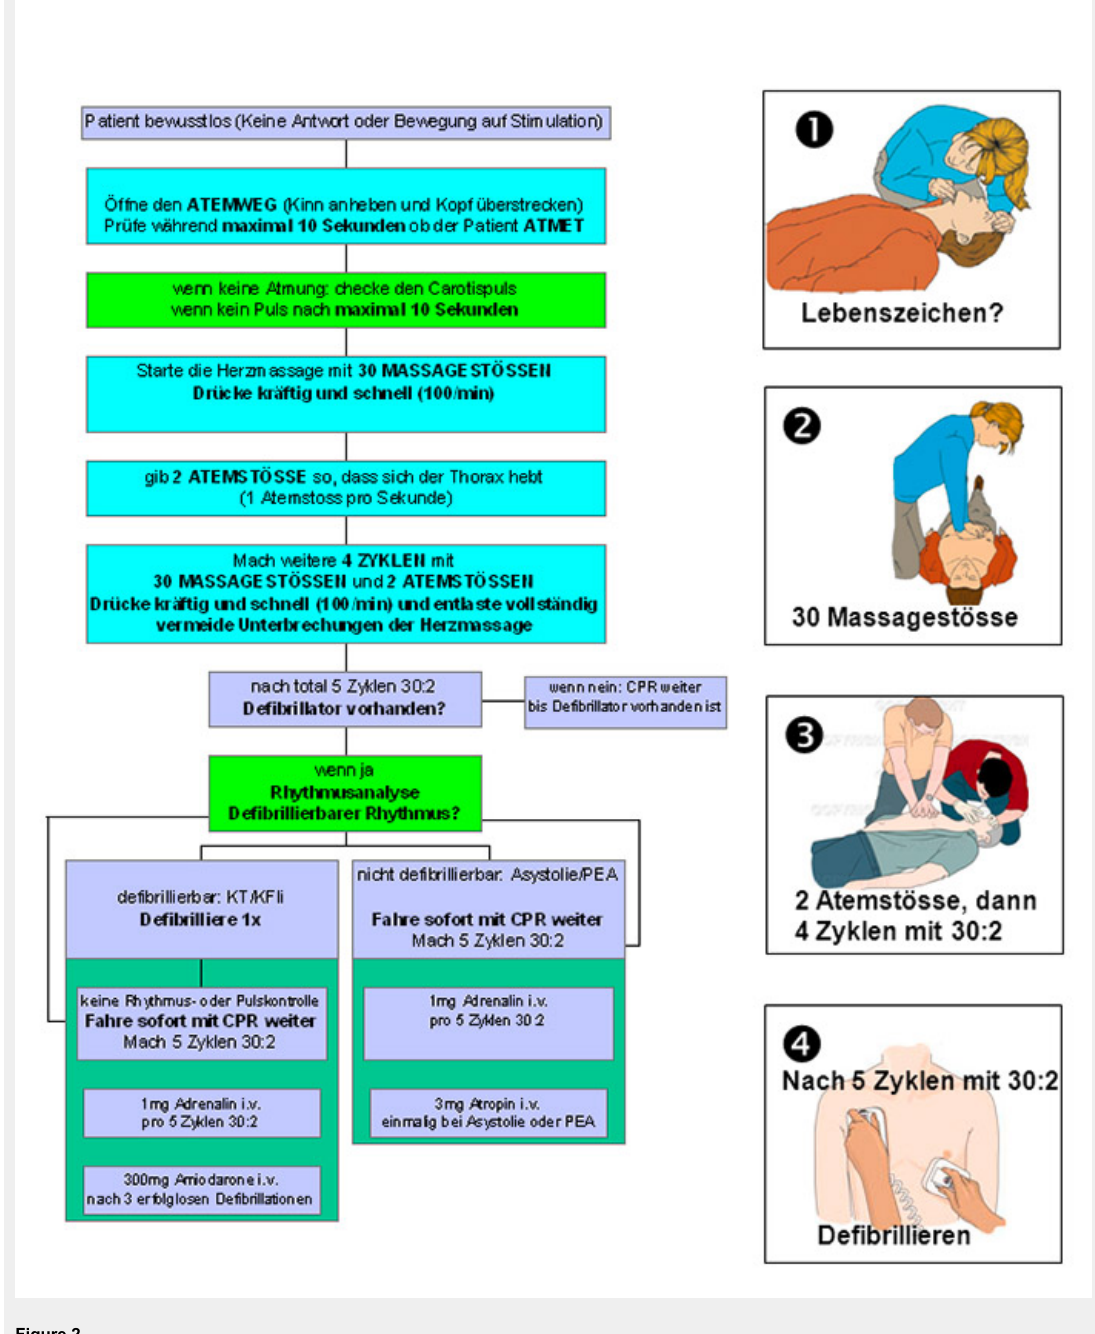
Figure 2 Instruction of the CAB algorithm corresponding to the 2005 guidelines of the European Resuscitation Council [6]. The instruction includes illustrations from the electronic version of the 2005 guidelines of the American Heart Association [8] and the European Resuscitation Council [6]. Reprint with permission of the